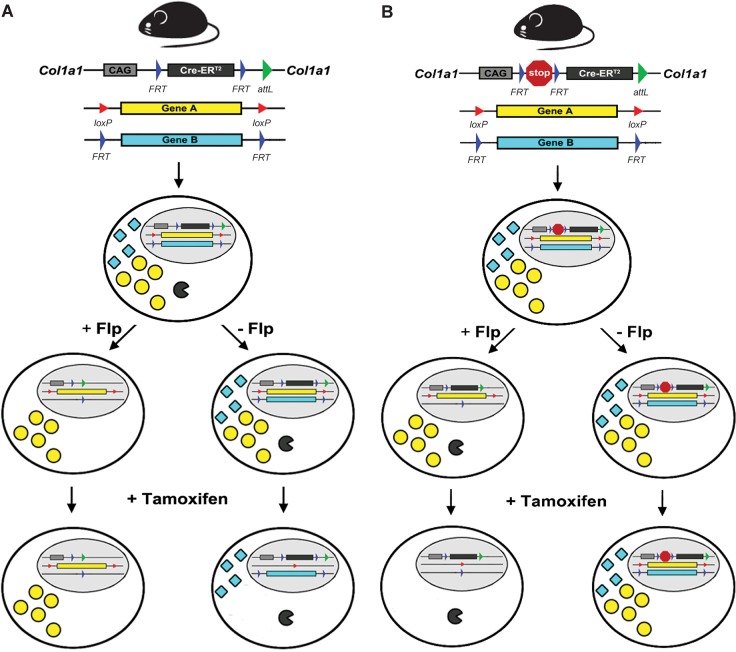
Sequential mutagenesis with Flp and Cre recombinases in Col1a1FRT-Cre-ER-T2-FRT and in Col1a1FRT-STOP-FRT-Cre-ER-T2 mice. (A) Col1a1FRT-Cre-ER-T2-FRT mice will express Cre-ERT2 recombinase ubiquitously from the Col1a1 locus. Exposure to Flp leads to excision of the Cre-ERT2 coding sequence flanked by FRT sites in the same cell and terminates Cre recombinase expression. Any other DNA flanked by FRT sites will be excised at the same time. Therefore, in these cells, subsequent tamoxifen exposure does not lead to Cre-mediated recombination of loxP sites. Without prior exposure to Flp, tamoxifen leads to Cre-ERT2 translocation into the nucleus and excision of loxP sites. (B) Col1a1FRT-STOP-FRT-Cre-ER-T2 mice do not express Cre-ERT2 at baseline. Cells exposed to Flp undergo excision of FRT sites including the STOP cassette upstream of Cre-ERT2, which results in transcription of Cre-ERT2. Subsequent tamoxifen exposure then leads to Cre-mediated recombination of loxP sites specifically in these cells. Cells without prior exposure to Flp do not recombine loxP sites when exposed to tamoxifen.